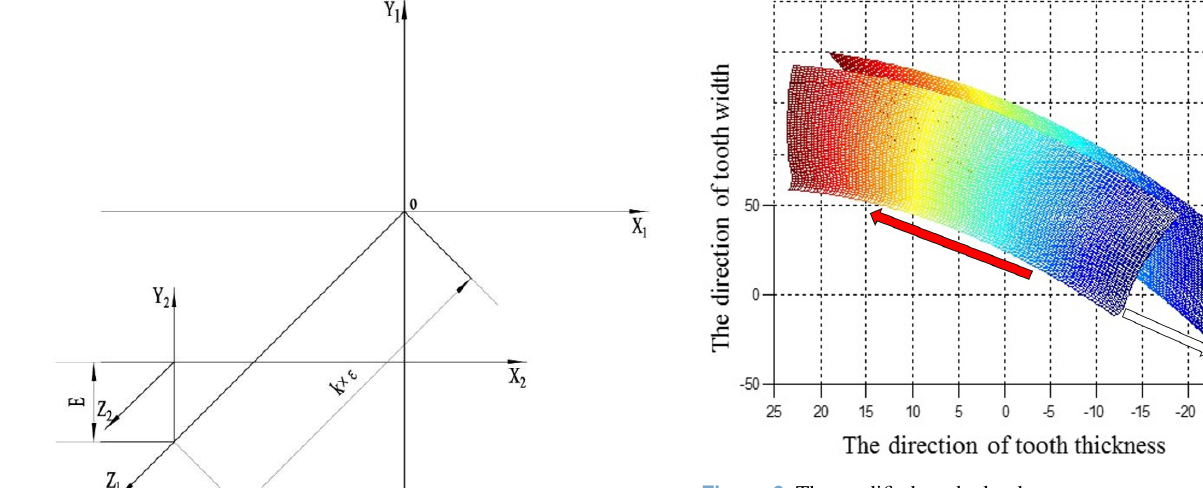
Figure 6. The modified tooth cloud.